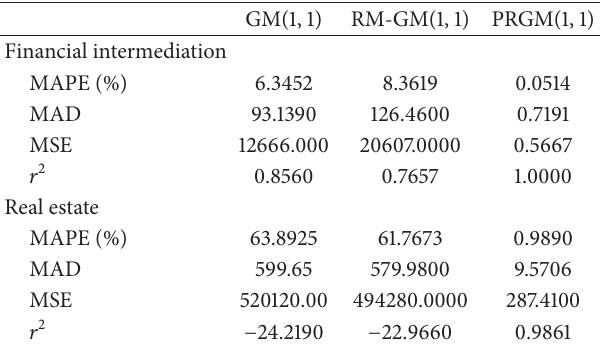
Table 3: The evaluation metrics to compare GM(1, 1), RM-GM(1, 1), and PRGM(1,